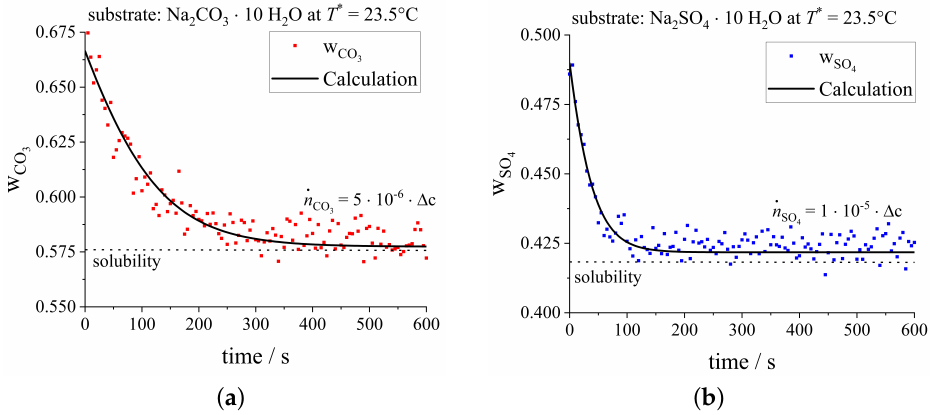
Figure 6. Diagram ( a ) displays the desupersaturation course of sodium carbonate decahydrate. In ( b ), the crystallization of sodium sulfate decahydrate is illustrated. The given equations were used to calculate the solid lines.